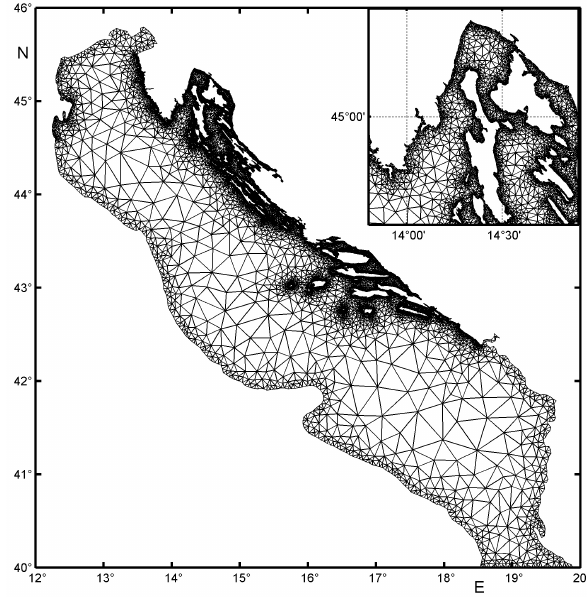
Fig. 3. Finite element mesh of the Adriatic Sea; inset in the upper right corner is a zoom on the larger Kvarner